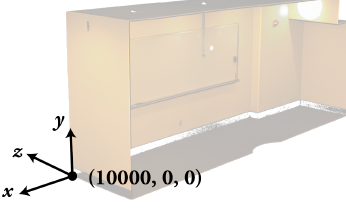
Figure 15. New datum after lateral alignment